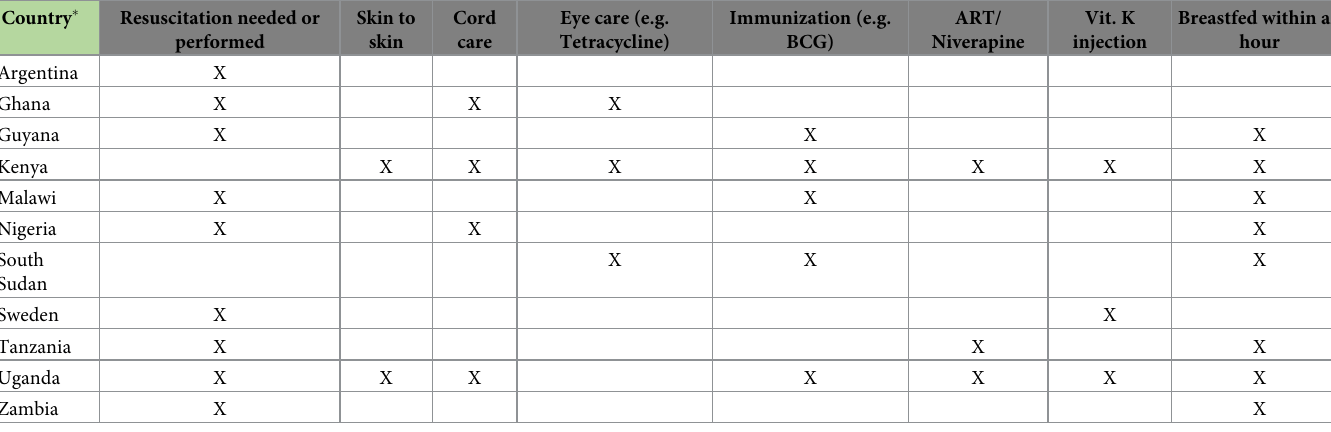
Table 6. Newborn care during the first hour of